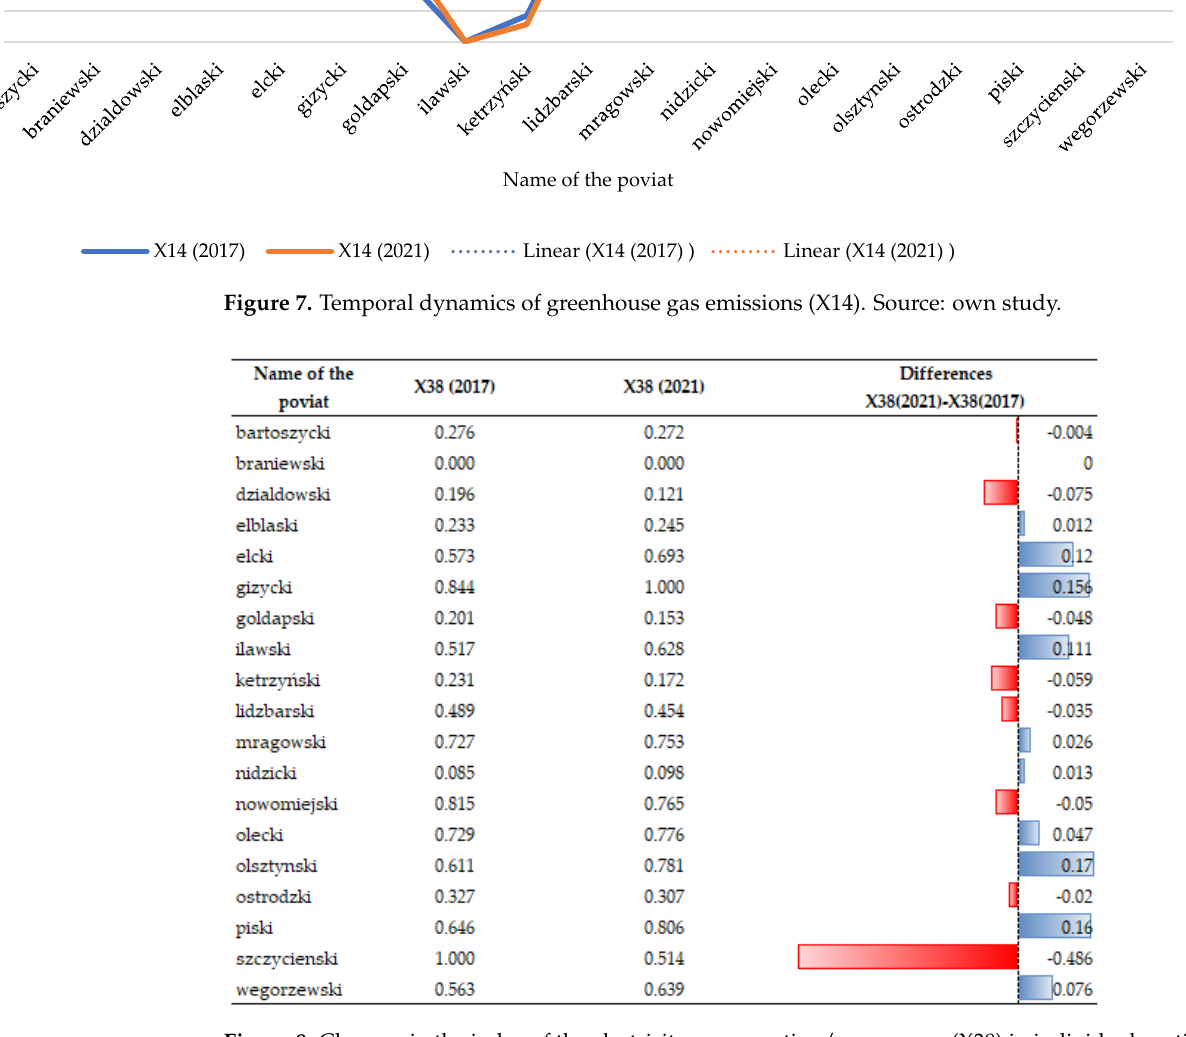
y = 0.0272x + 0.2051